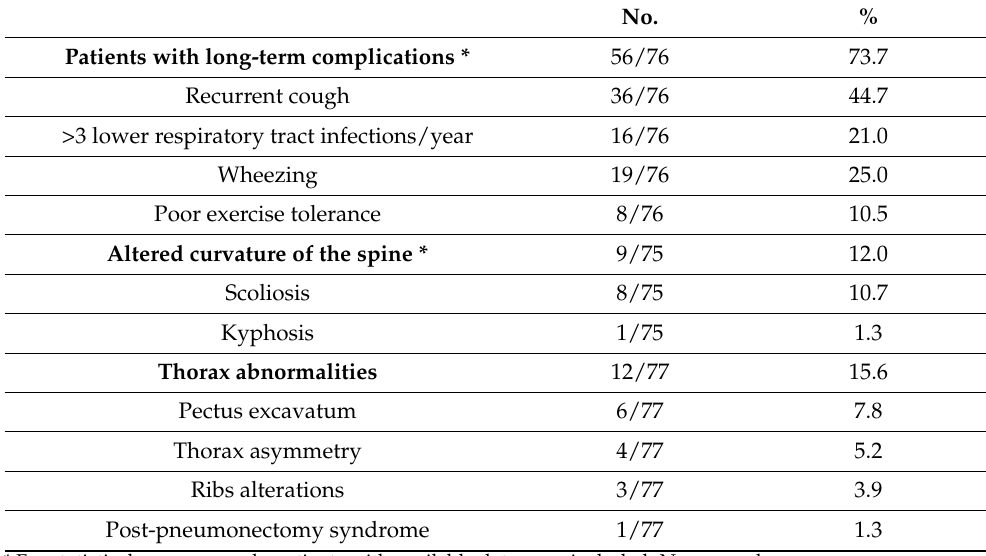
Table 2. Long-term post-surgery